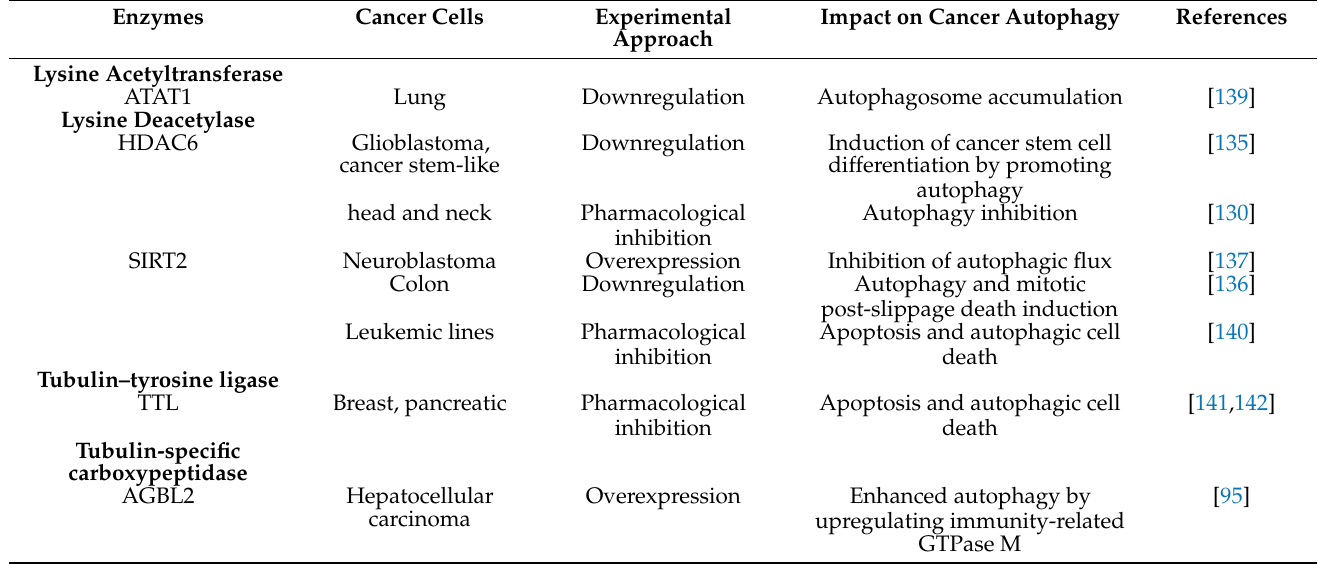
Table 4. Functional roles of tubulin-modifying enzymes in autophagy progression and cell